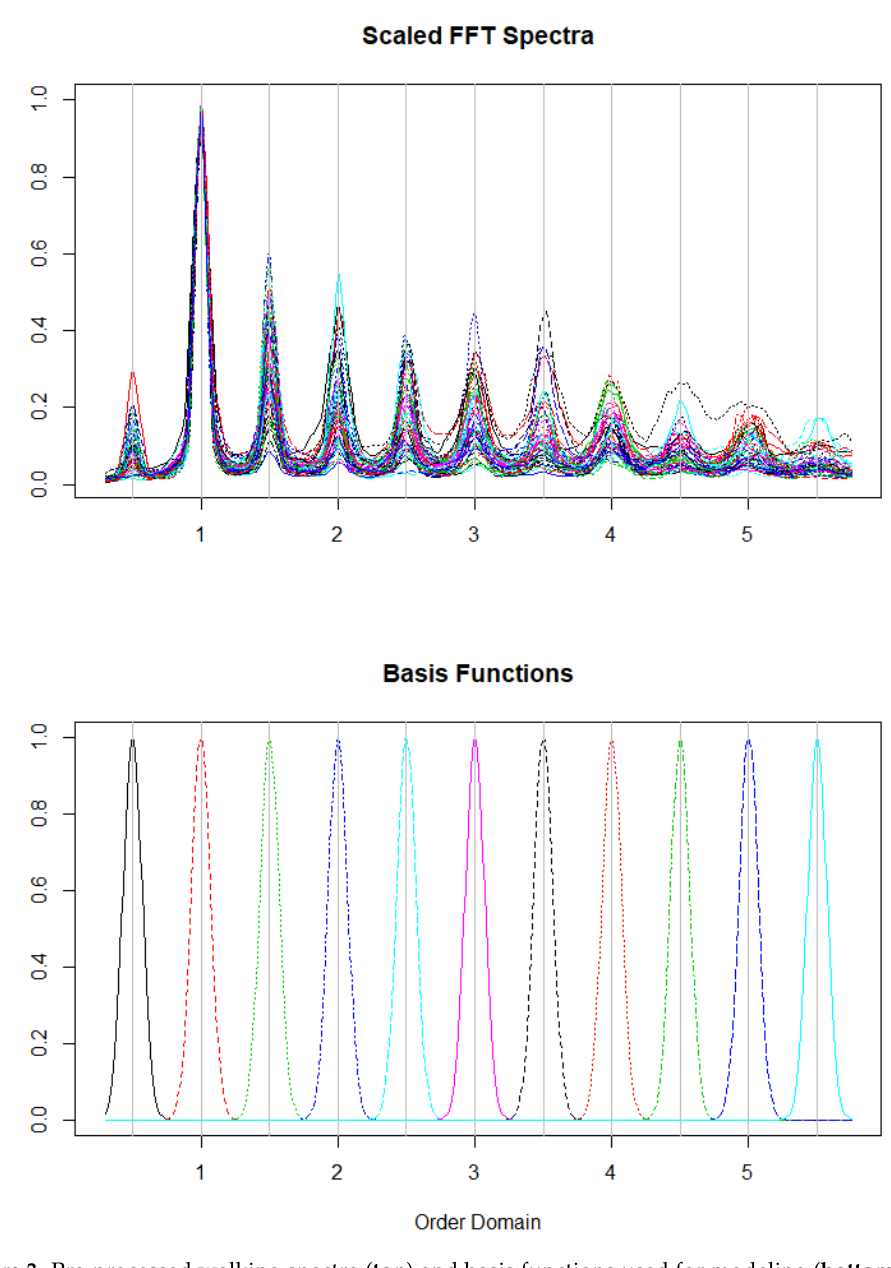
Figure 3. Pre-processed walking spectra ( top ) and basis functions used for modeling ( bottom ). The x -axis represents multiples of the frequency of the